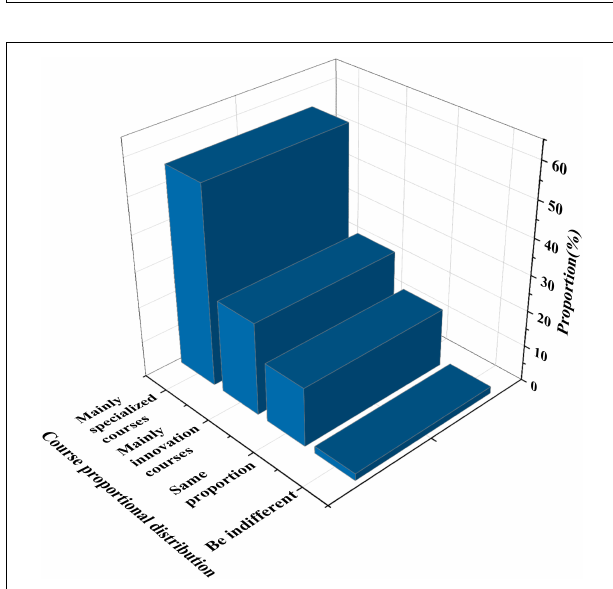
FIGURE 7 | Statistical chart of course allocation proportion.